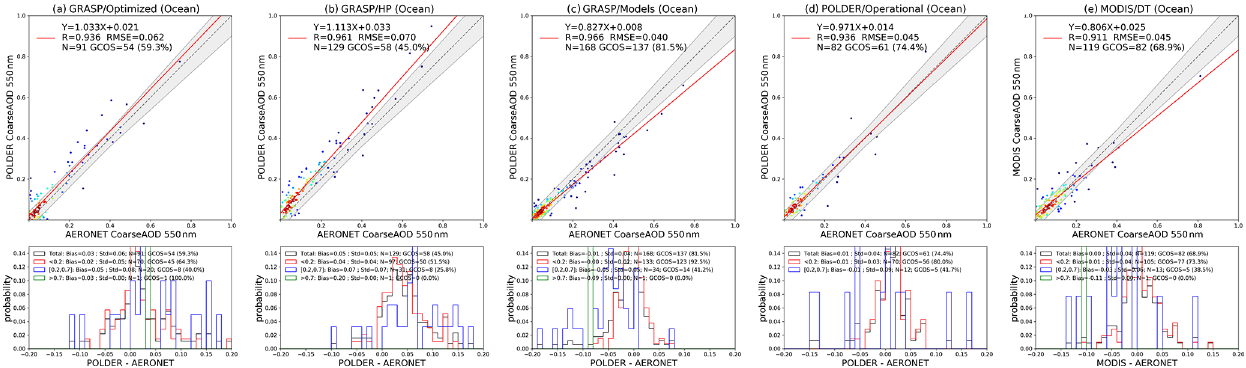
Figure 16. Validation of PARASOL/GRASP ( a GRASP/Optimized, b GRASP/HP and c GRASP/Models), (d) PARASOL/Operational and (e) MODIS/DT coarse-mode AOD at 550nm over ocean in 2008. The gray envelope indicates GCOS requirement applied for AODC: max (0.04 or 0.1AODC). The probability density functions of differences (POLDER–AERONET) are present in the lower panels. The black, red, blue and green solid lines indicate all AODC conditions: any AODC, AODC < 0.2, 0.2 ≤ AODC ≤ 0.7 and AODC > 0.7,